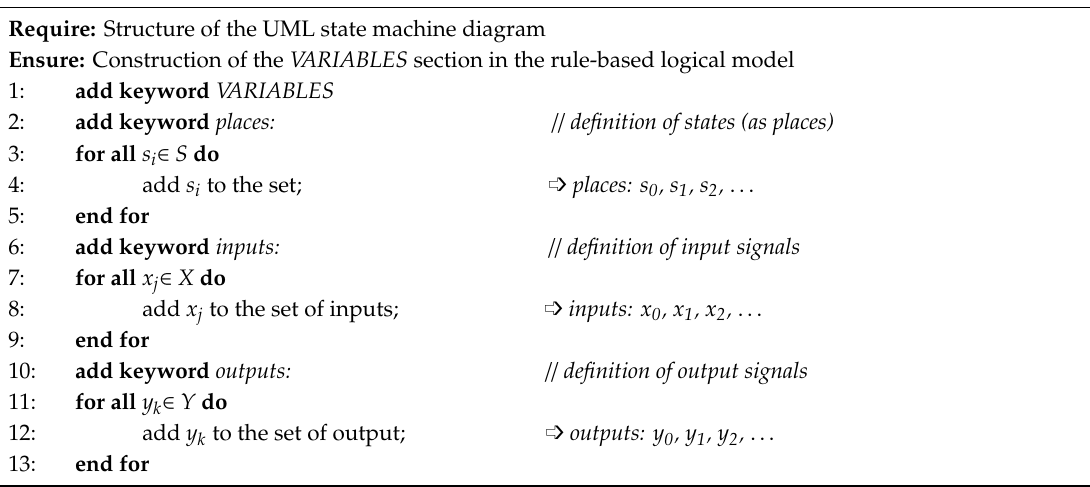
Algorithm 1. Generation of the VARIABLES section in the rule-based logical